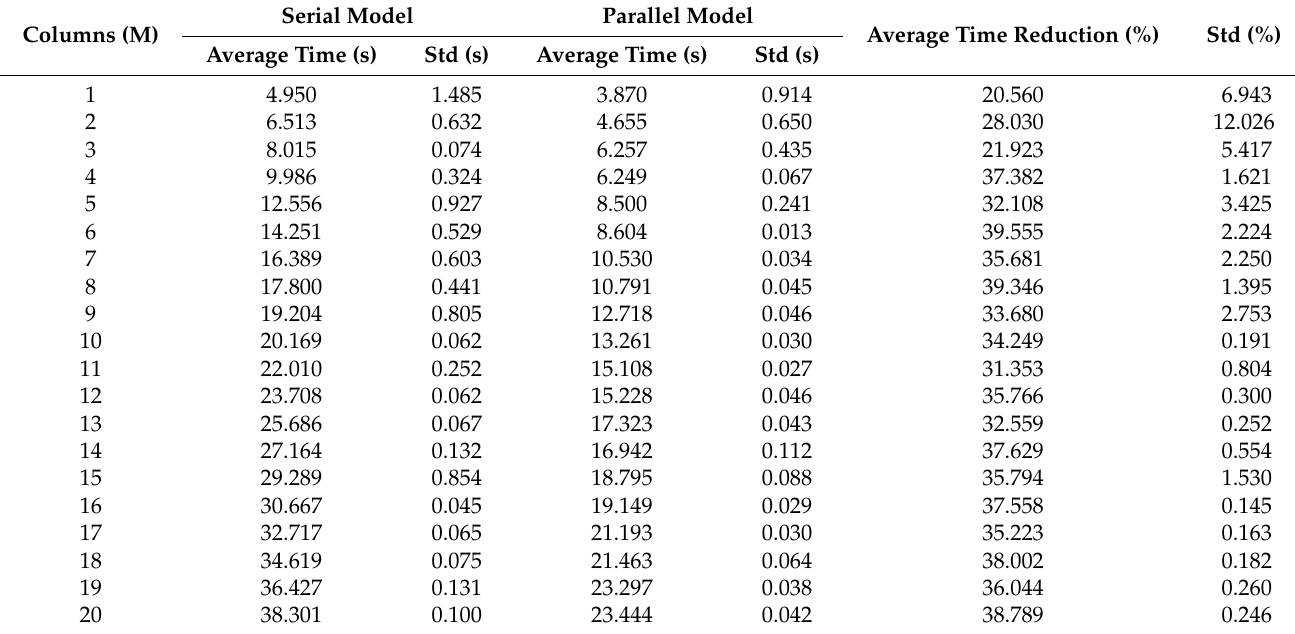
Figure 6. Calculation time scalability analysis for an SP array with 15 rows ( N = 15) and columns varying from 1 to 20 ( M = [ 1 · · · 20 ] ). Table 1. Average calculation time and standard deviation (std) for an SP array with 15 rows ( N = 15) and columns varying from 1 to 20 ( M = [ 1 · · · 20 ]